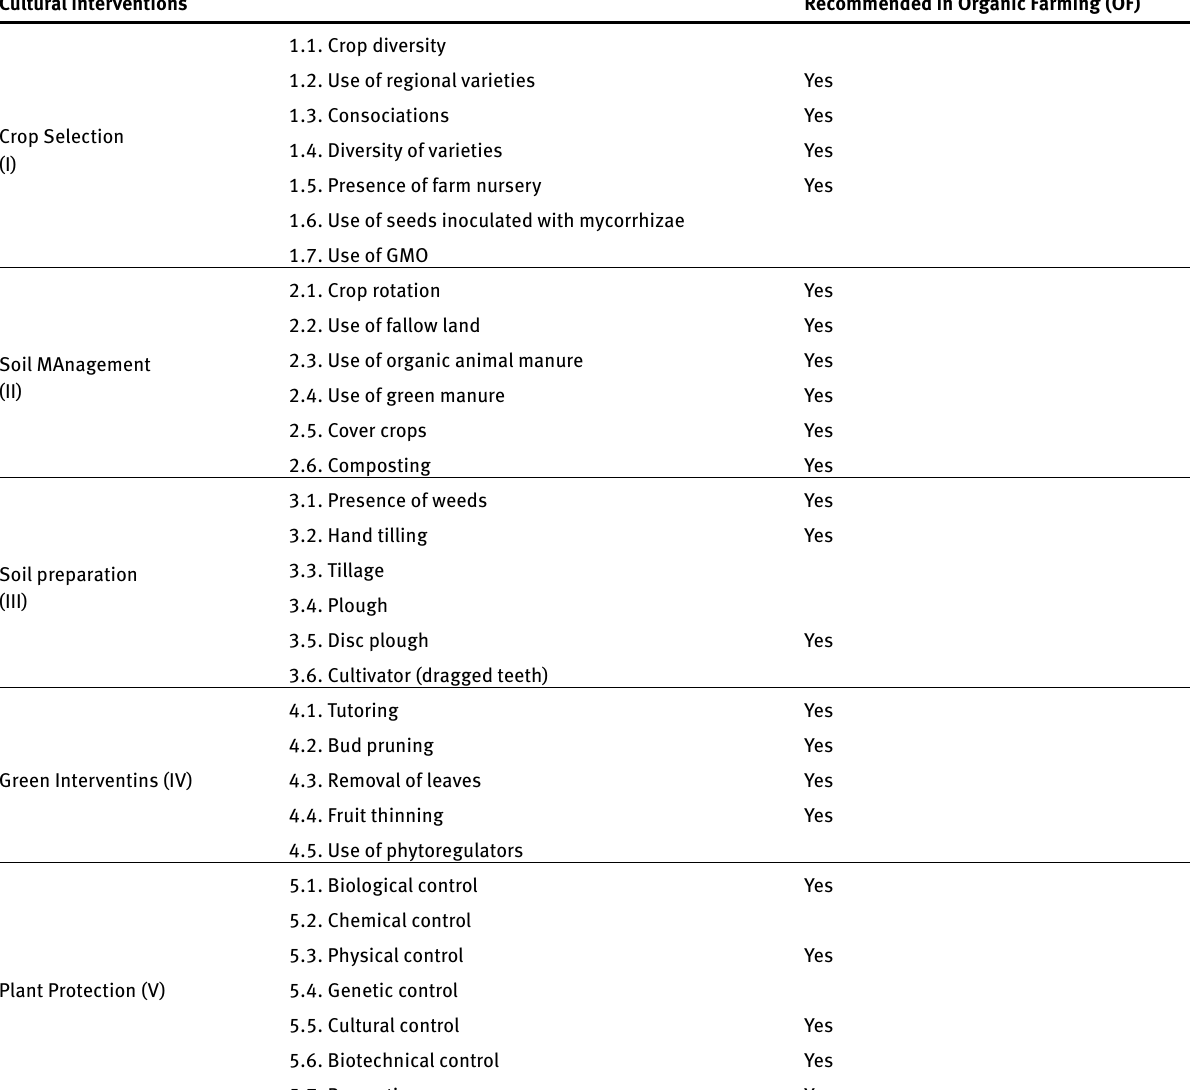
Table 1: Variables included in the checklist Cultural